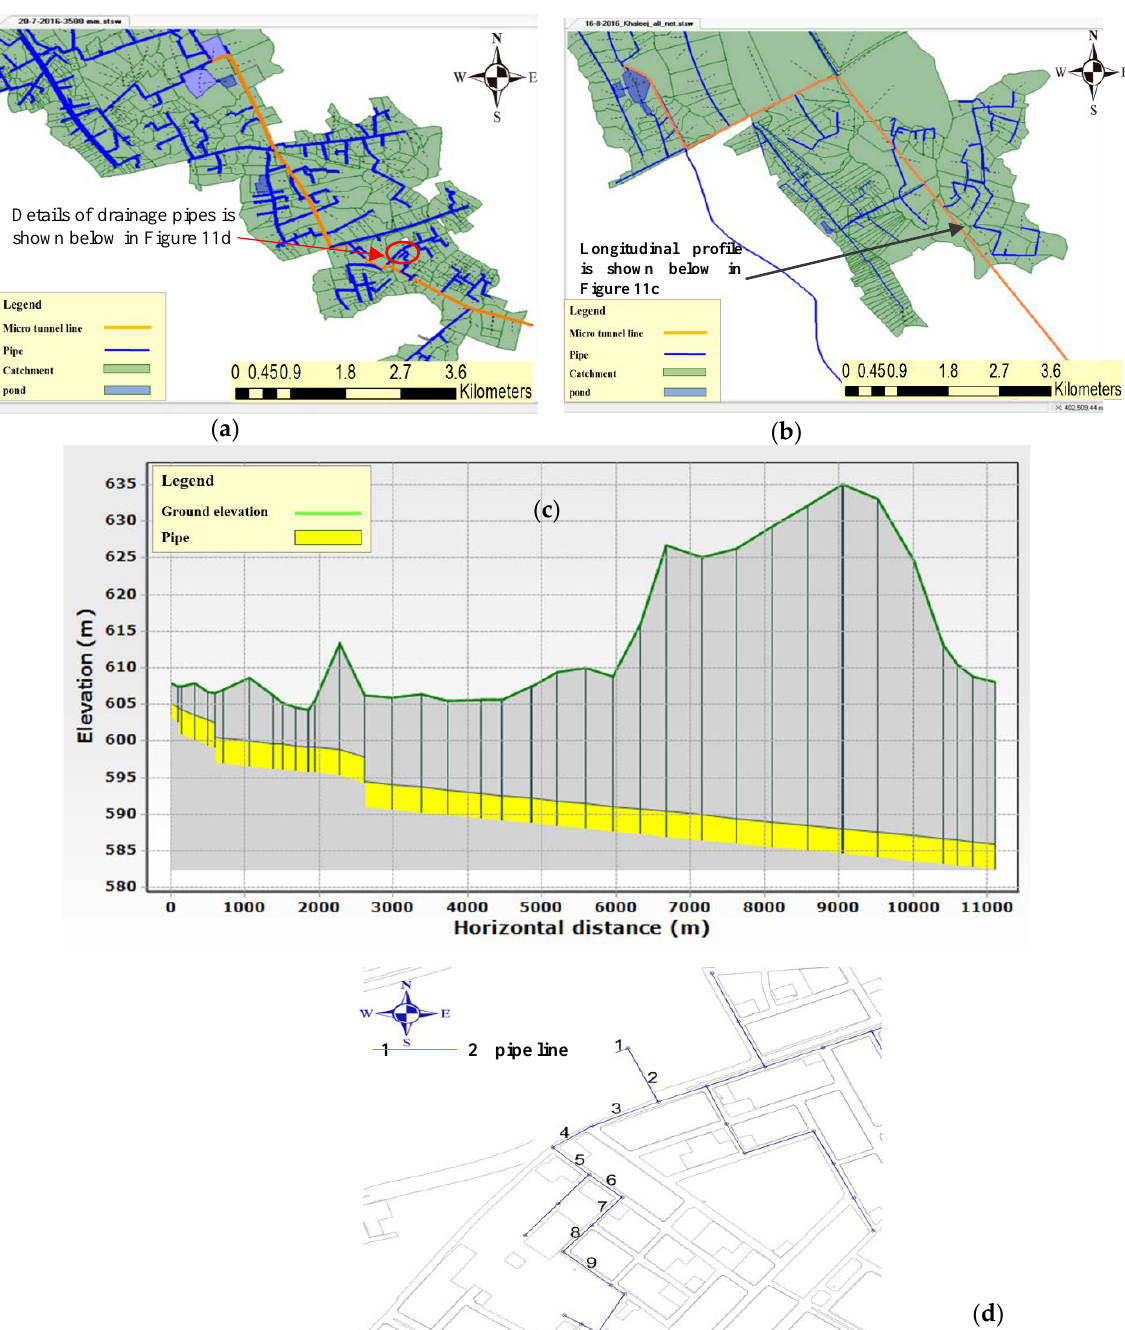
Figure 11. Hydraulic model prepared using SewerGEMS software, ( a ) Al Naqaa catchment ; ( b ) Al Khaleej catchment; ( c ) Longitudinal profile of micro-tunneling option for Al Khaleej catchment and ( d ) Details of drainage pipes given in table 5 (a part of Al Naqaa catchment)